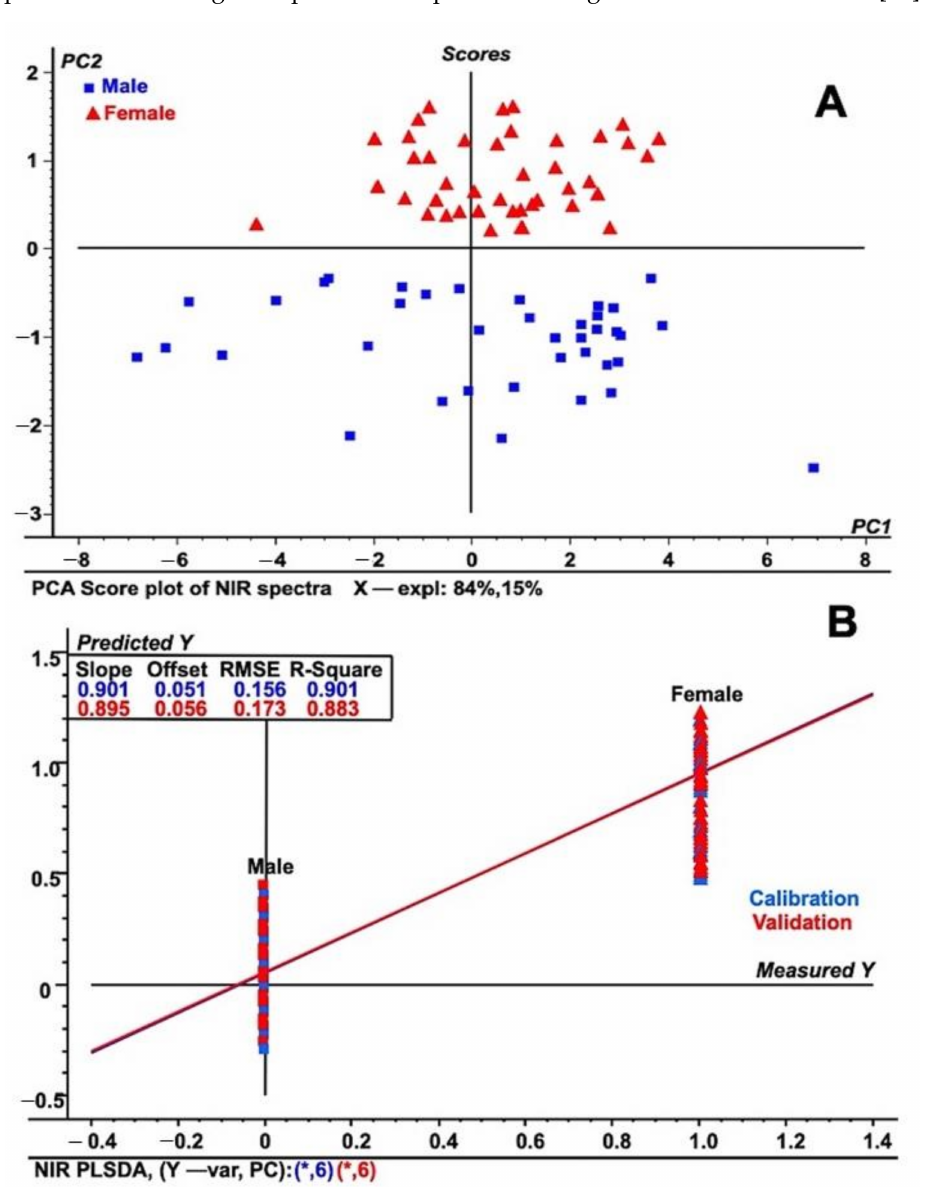
Figure 2. Regression analysis used for immature date palm leaf samples ( A ) PCA score plot of NIR spectral data for both male and female leaf samples from immature date palms. ( B ) PLS-DA plot using NIR spectral data from both male and female date palm leaf samples. The figure shows both the calibration and validation of the tested samples using spectral data in the wavenumber range of 4000 to 10,000 cm − 1 . The spectra represent the fifty individual samples each from male and female and that were tested five